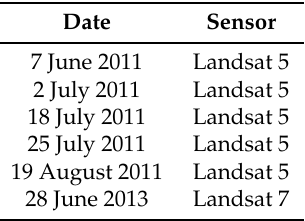
Table 1. Satellite acquisition dates and